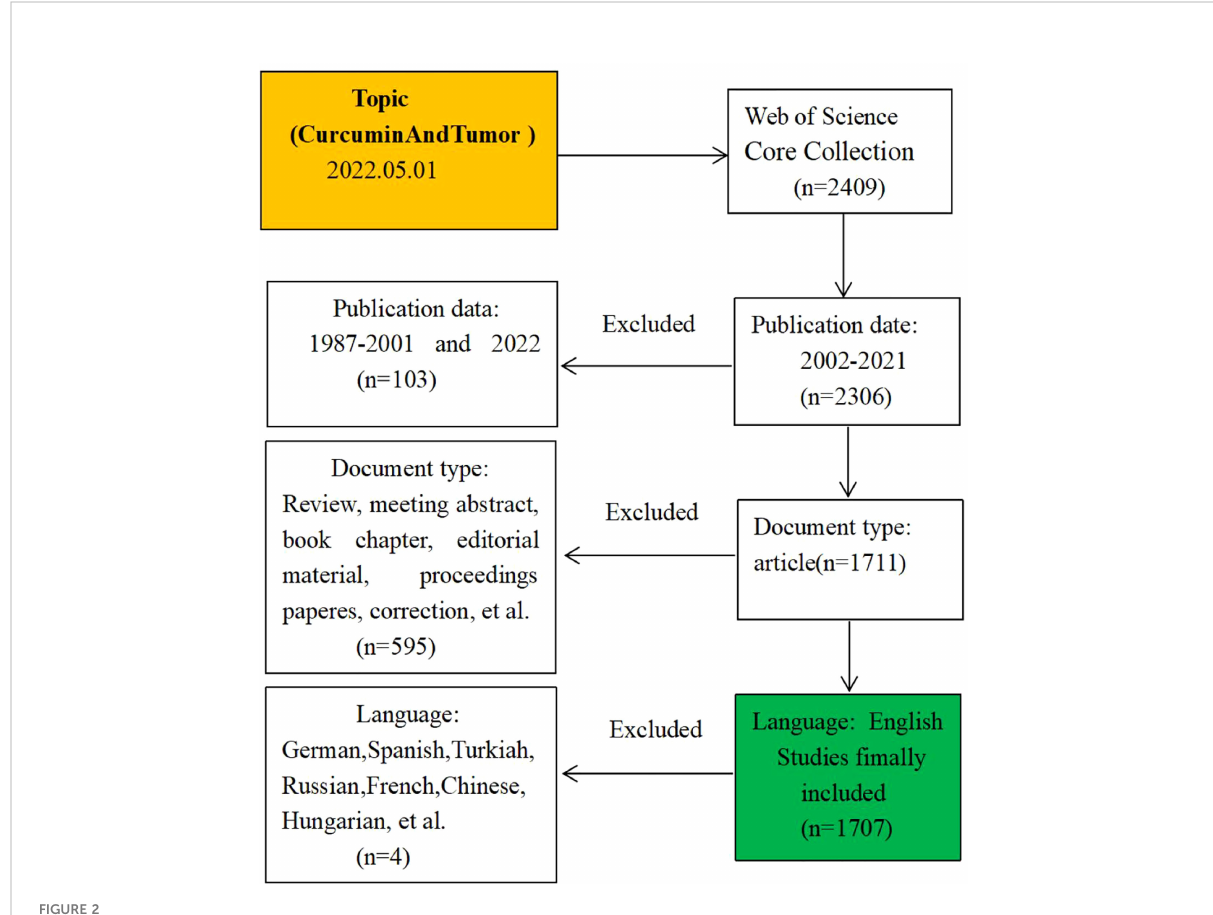
FIGURE 2 The inclusion criteria for paper